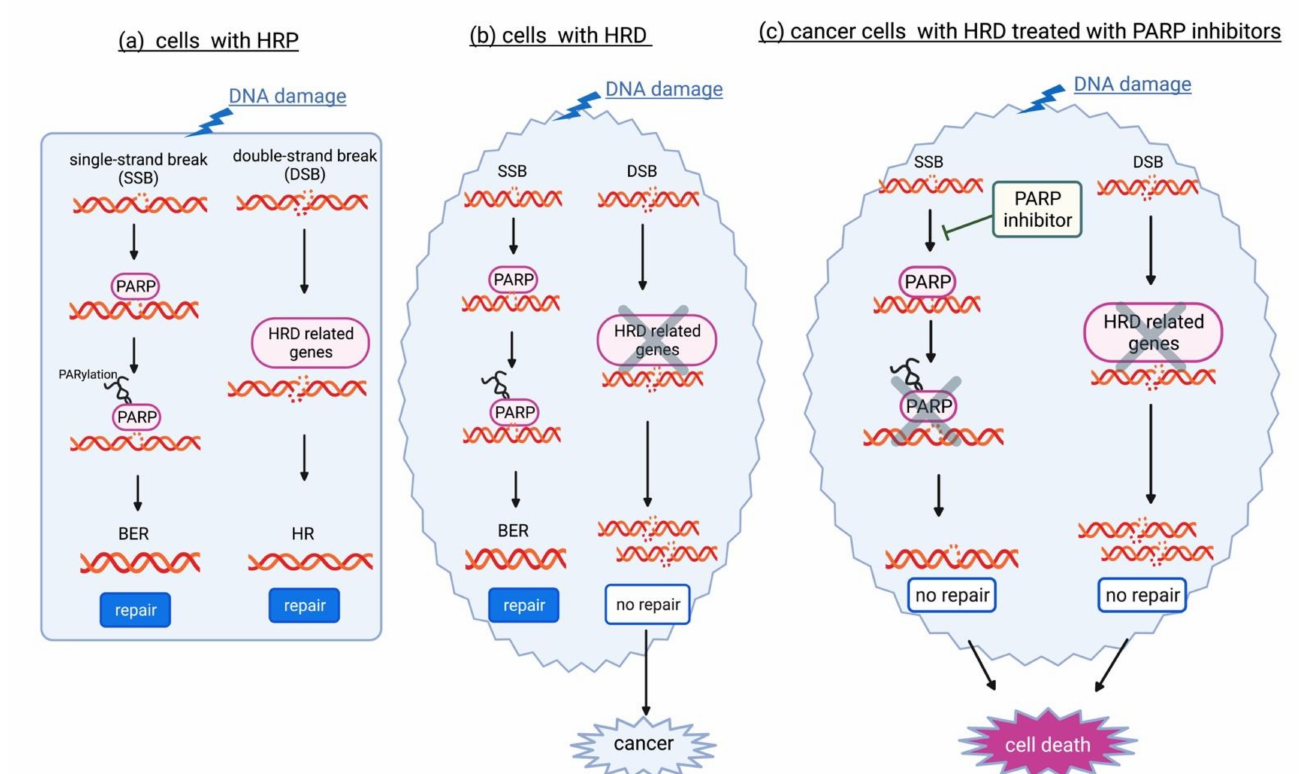
Figure 2. In normal cells which are proficient in homologous recombination (HRP), both base excision repair (BER) and HR are available for the repair of damaged DNA via poly (ADP-ribose) polymerase (PARP) and proteins encoded by HR deficiency (HRD)-related genes, respectively ( a ). In cells with HRD, HR is nonfunctional and leads to carcinogenesis ( b ). When PARP is inhibited by PARP inhibitor, cancer cells with HRD are unable to repair DNA damage by HR and BER, resulting in cell death (synthetic lethality) ( c